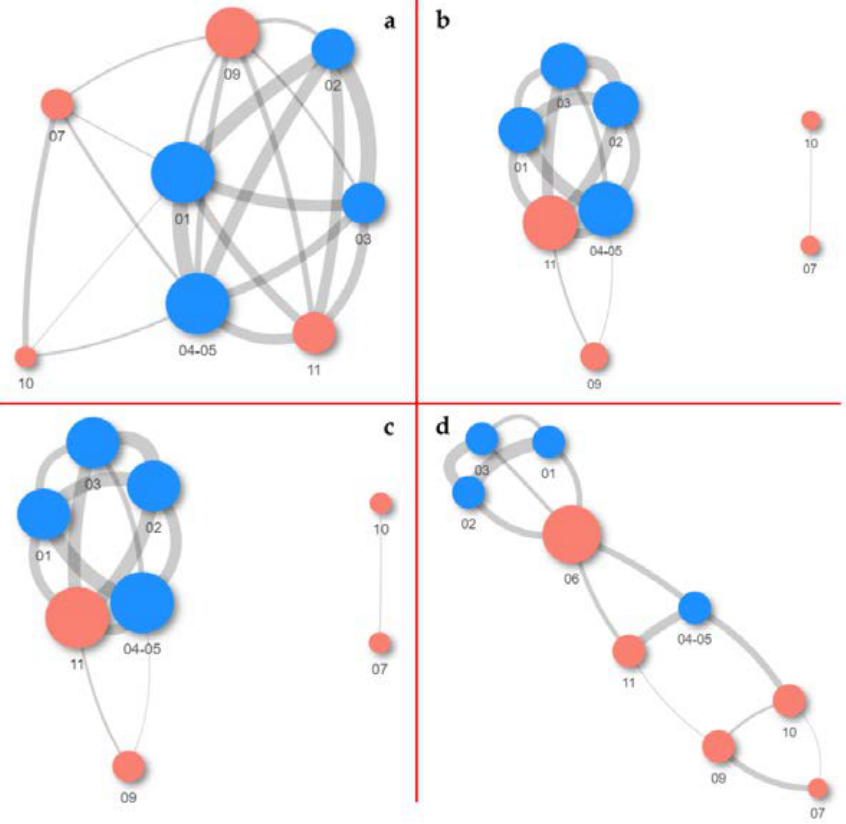
Figure 9. Network analysis of samples with weighted UniFrac distances at the: ( a ) ASV; ( b ) genus; ( c ) family; and ( d ) phylum taxa levels. Node size corresponds to the number of connections, while edge width corresponds to the distance among samples (closer distances equal wider edges). Red nodes are from the samples around the fresco, while blue nodes are the fresco’s samples.